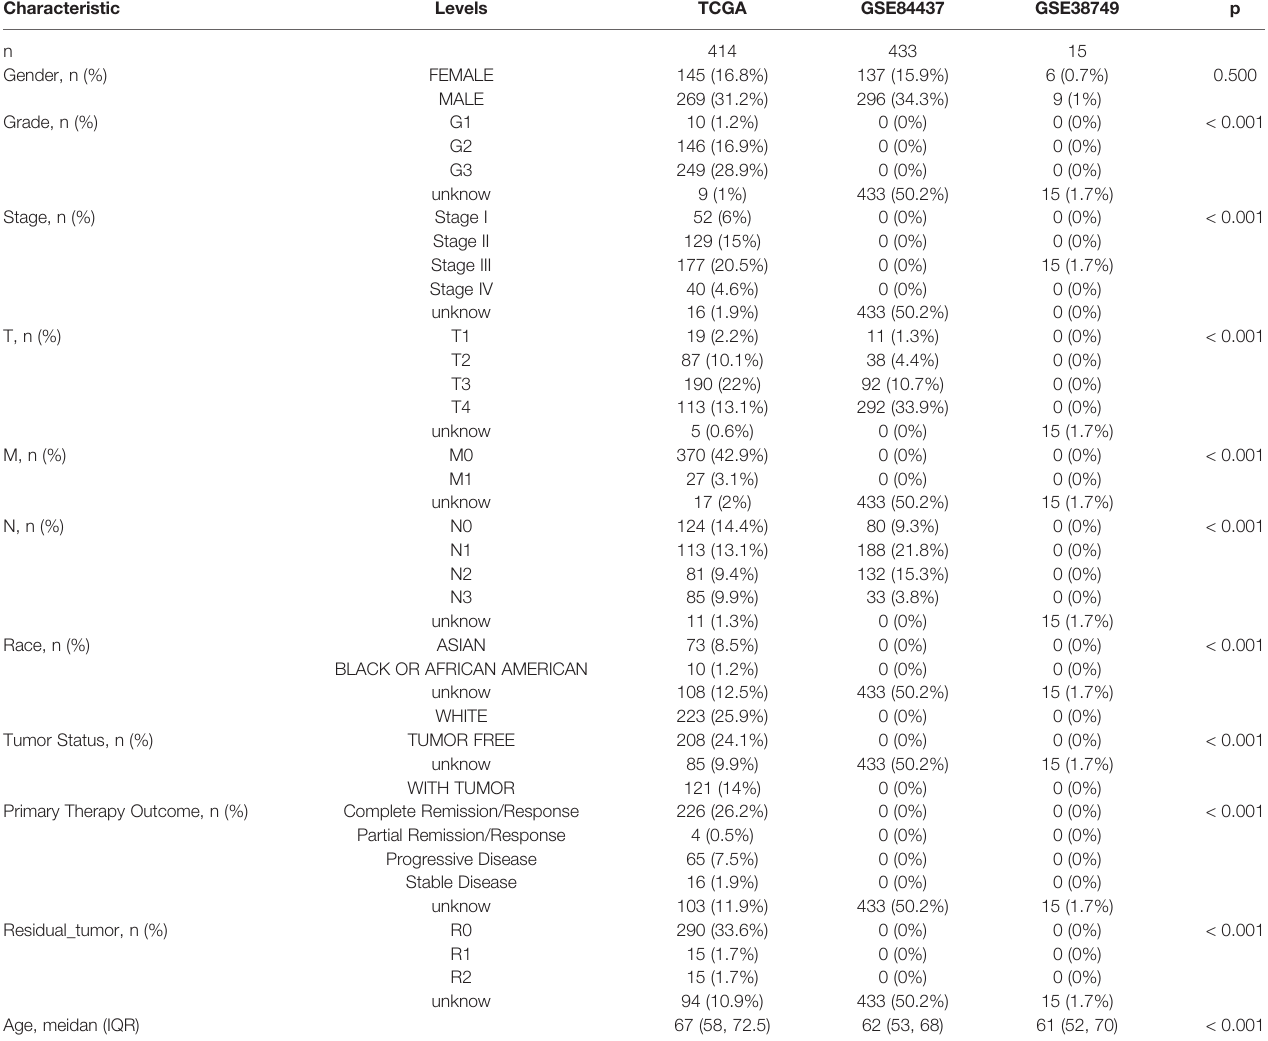
TABLE 1 | Basic characteristics of STAD patients. Characteristic